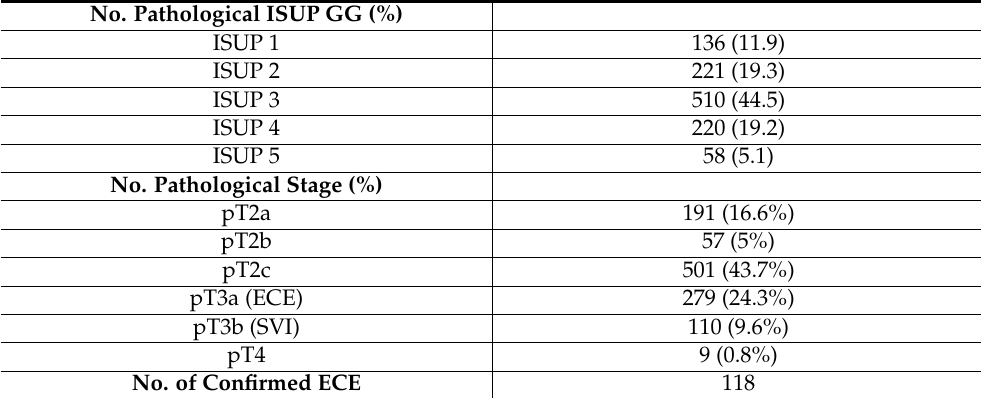
Table 2. Pathological postoperative characteristics (N =